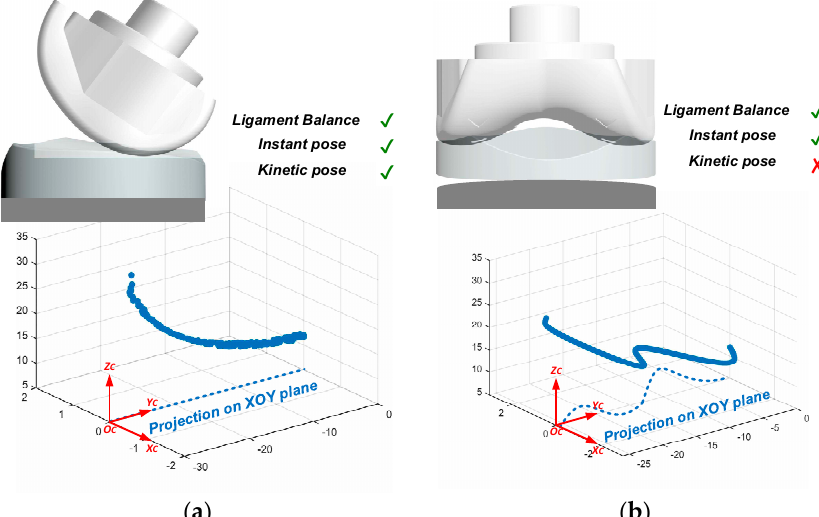
Figure 18. Examples of kinetic pose reconstruction: ( a ) successful surgery gives smooth kinetic trajectory, ( b ) kinetic trajectory finds inappropriate surgery which cannot be found using force measurement or instant pose